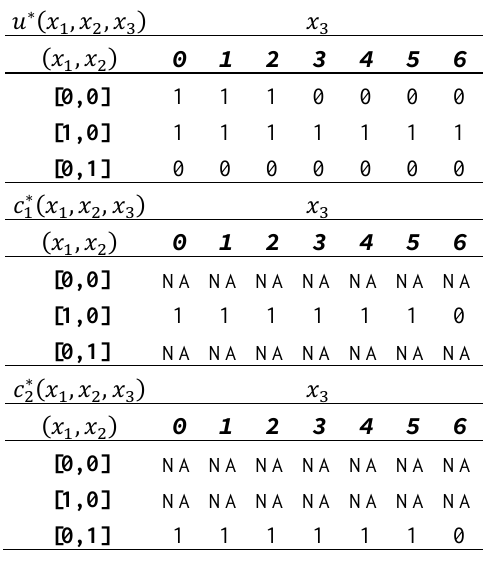
Table 2. Optimal production decisions, s=1,